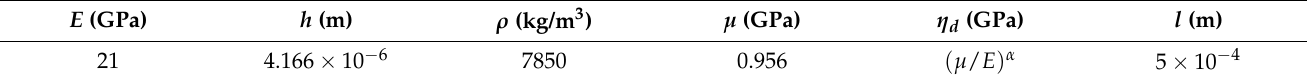
Table 5. Values of the